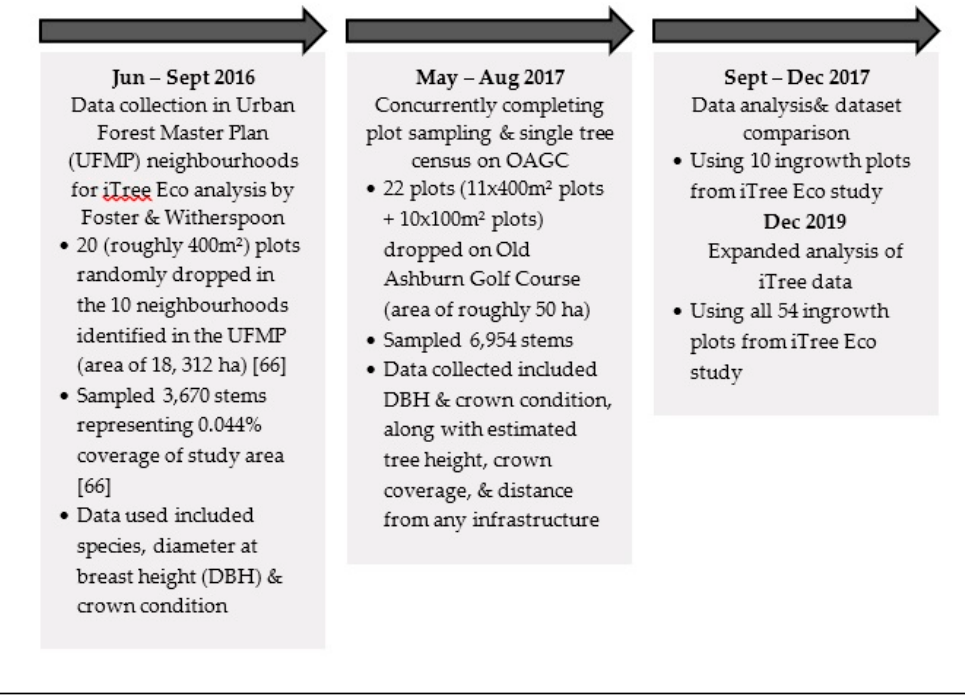
Figure 4. Flow chart of methods